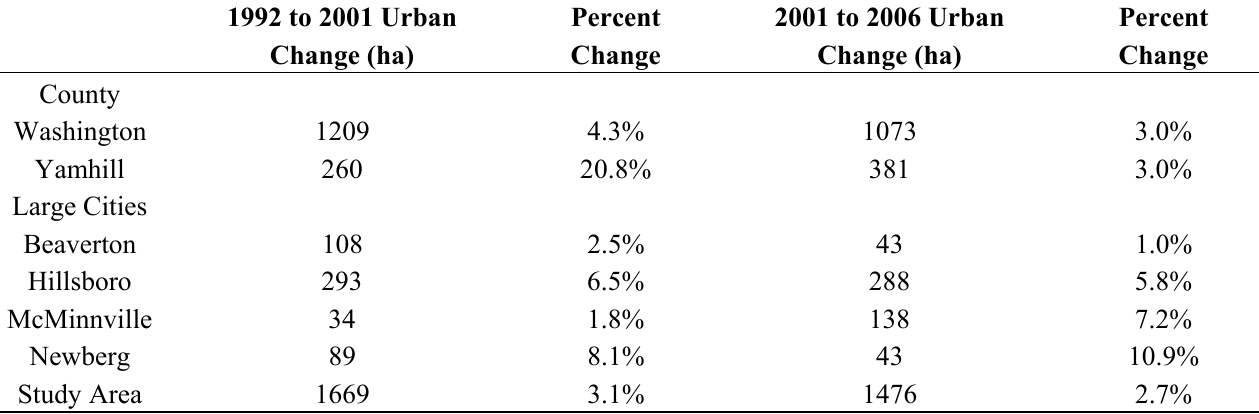
Table 2. Change in urban land cover classes for two counties and select cities in the study area. Change based on National the Land Cover Dataset (NLCD) 1992–2001 land cover change retrofit product [34] and the 2001 and 2006 NLCD